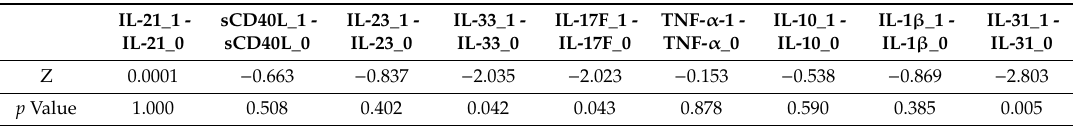
Table 4. Comparison between the initial and final cytokine values in the naïve patient group (Wilcoxon’s